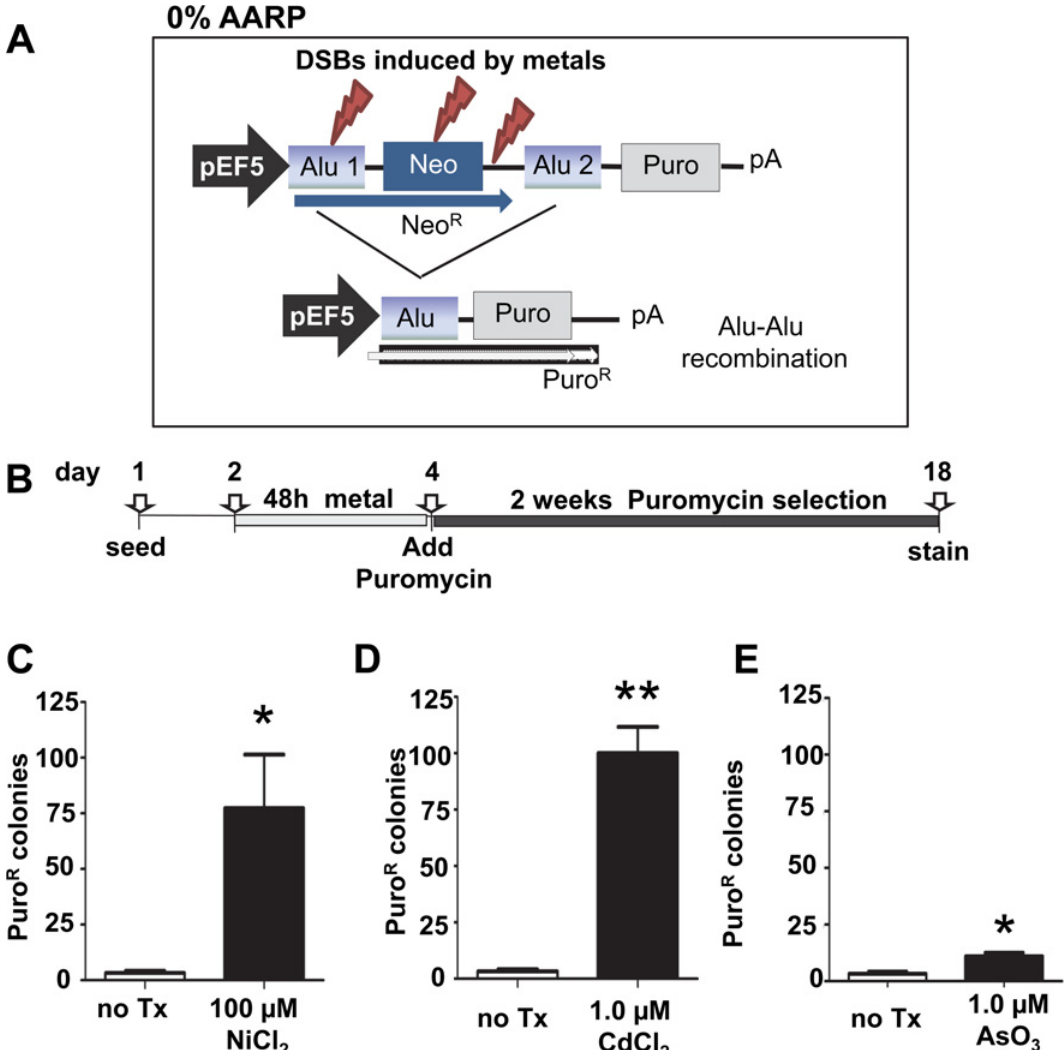
Fig 2. Exposure to heavy metals induces deletion events. A. A schematic of the 0% AARP cassette is shown. The cassette is stably integrated into an FRT site of the HEK293 cell line. The basic construct consists of a promoter upstream of two identical Alu sequences ( i . e . 0% divergence between Alu1 and Alu2) separated by approximately 1.1 kb which contains an I- Sce I site. The vector is designed so that only Neo (blue) is expressed driven by the pEF5 promoter (gray arrow). DSBs can be exogenously induced by transfection of an I- Sce I expression vector or to evaluate induction of DSBs by xenobiotics like heavy metals. In this approach, only those DSBs generated by metal exposure that occur near the cassette sequences are detectable. Events that are repaired by deleting the sequence between the Alus will allow expression of Puro R (light gray). All events detected by this assay are repair events that result in a mutagenic outcome. Neo = neomycin resistance gene, pA = polyadenylation signal, Puro = puromycin resistance gene, pEF5 = elongation factor 5 promoter B. A schematic of the protocol of the time line of the assay is shown. Cells are seeded and 16 – 24h later they are exposed to medium with or without the heavy metal for 48 h. Then the medium is removed and replaced puromycin medium for selection. Fourteen days post-selection, cells are stained in crystal violet solution and the puro R colonies are counted. Three heavy metals were evaluated: C. 100 μ M NiCl 2 D. 1 μ M CdCl 2 and E. 1 μ M AsO 3 . Data represent the mean with standard error of the mean from at least three independently experiments for each condition. Statistical differences are indicated as * P < 0.05; ** P < 0.001 (two-tailed two sample Student ’ s